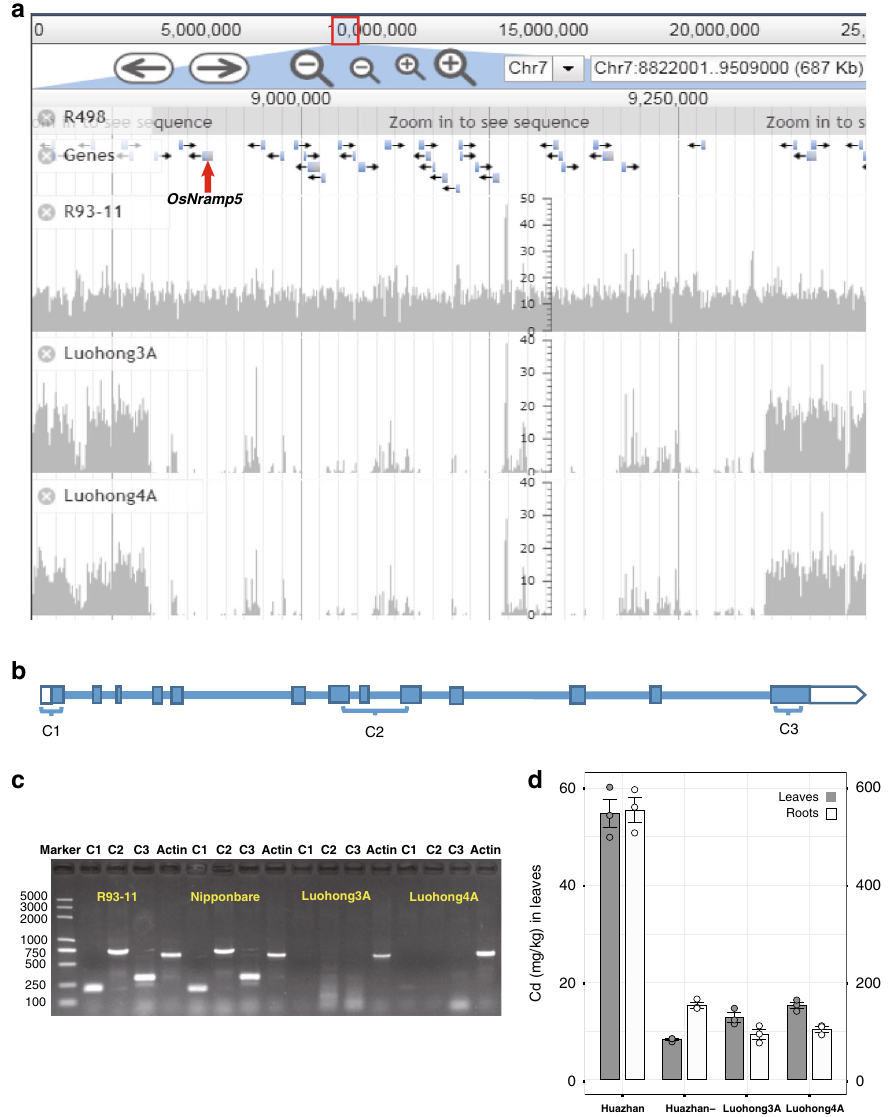
Fig. 4 Genetic variation in OsNramp5 in Luohong3A and Luohong4A. a Deletion that spans OsNramp5 (marked by the red arrow) in Luohong3A and Luohong4A shown using JBrowse 52 (v1.12.3). R93-11, a commonly used 2R, was used as a control to demonstrate no large deletion. b Gene structure of OsNramp5 in Nipponbare showing the location of regions used for PCR: C1 on exon 1, C2 on exons 7 and 9, and C3 on exon 13. c Agarose gel electrophoresis of PCR products for accessions R93-11 (positive control), Nipponbare (positive control), Luohong3A, and Luohong4A using three pairs of primers targeting the C1, C2, and C3 regions shown in b . The rice actin gene served as the PCR DNA control. The marker sizes (bp) are shown on the left side. Three biological replicates were analyzed for each sample and a representative gel image is shown. d Bar plot for Cd content in leaves (dark) and roots (white) of Huazhan (positive control), Huazhan- OsNramp5 ( OsNramp5 knockout 39 , negative control), Luohong3A, and Luohong4A. Mean values± s.d. ( n = 3) are shown. All individual data points are shown as dots. Source data underlying c and d are provided as a Source Data fi